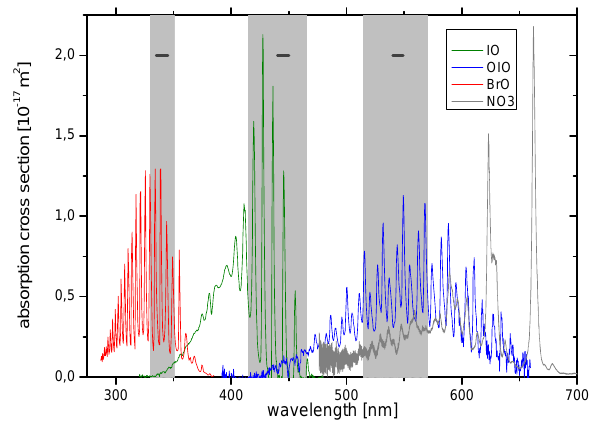
Fig. 8. Absorption cross sections of BrO (red), IO (green), IOI Figure 8. Absorption cross sections of BrO (red), IO (green), IOI (blue) and NO 3 (dark grey) 2 (blue) and NO 3 (dark grey) combined with the spectral regions of combined with the spectral regions of high reflective (R~0.9998) mirrors (light grey bars) and 3 high reflective ( R ∼ 0 . 9998) mirrors (light grey bars) and high lumi- nosity LEDs (grey horizontal lines) available from stock. Data from high luminosity LEDs (grey horizontal lines) available from stock. Data from UV-VIS 4 UV-VIS Absorption Spectra of Gaseous Molecules and Radicals: Absorption Spectra of Gaseous Molecules and Radicals: 5 http://www.atmosphere.mpg.de/enid/2295/, accessed: 2 November http://www.atmosphere.mpg.de/enid/2295/, accessed: 2 November 2007. 6